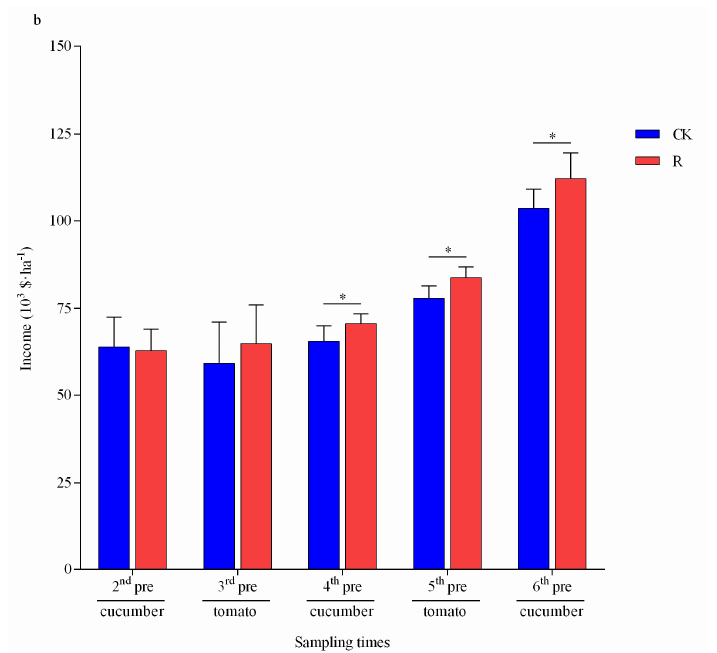
Figure 5. The fruit yield ( a ) and the income of fruit yield ( b ) after in situ vegetable residue return. CK, the non-vegetable residue treatment; R, the vegetable residue treatment; pre, the pre-returning stage; number from 2 to 6, the times of in situ vegetable residue return. Statistically significant differences were analysed between CK and R at each stage using t-test. *, p < 0.05. Vegetable from Shouguang holds a big market share in Beijing. The average sale prices of cucumber and tomato at the largest vegetable market in Beijing from 2017 to 2020 were approximately 0.92 USD·kg − 1 and 1.01 USD·kg − 1 , respectively.